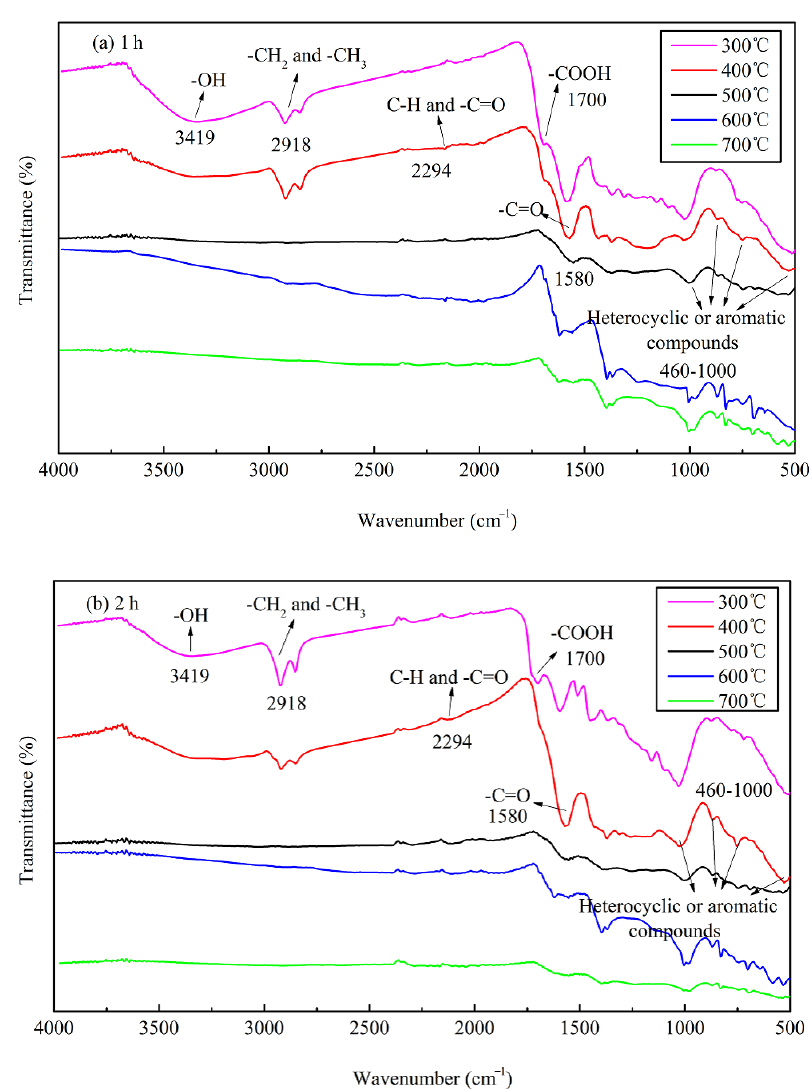
Figure 5. FTIR spectrograms of JB under different carbonization conditions. ( a ) for 1 h; ( b ) for 2 h.